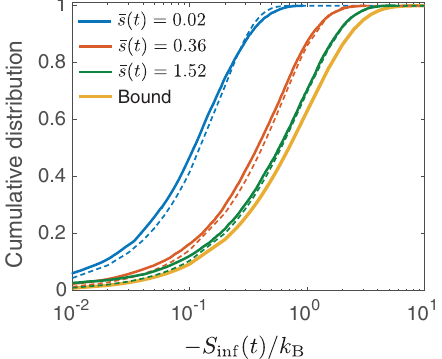
FIG. 6. Mean of the finite-time entropy-production infimum h S inf ð t Þi as a function of the mean entropy change ¯ s ð t Þ ¼ h S tot ð t Þi =k B for a Smoluchowski-Feynman ratchet in a steady state. Simulation results for the Smoluchowski-Feynman ratchet with the potential (79) (symbols) are compared with analytical results for the drift-diffusion process given by Eq. (82) (dashed lines), and with the universal infimum law given by − k thick bar). Different symbols are obtained for different simulation time steps Δ t . Simulation parameters: 10 4 simulations with T 300 K, l ¼ 2 π nm, γ ¼ 8 . 4 pN s = nm, V env ¼ and total simulation time t ¼ 0 . 4